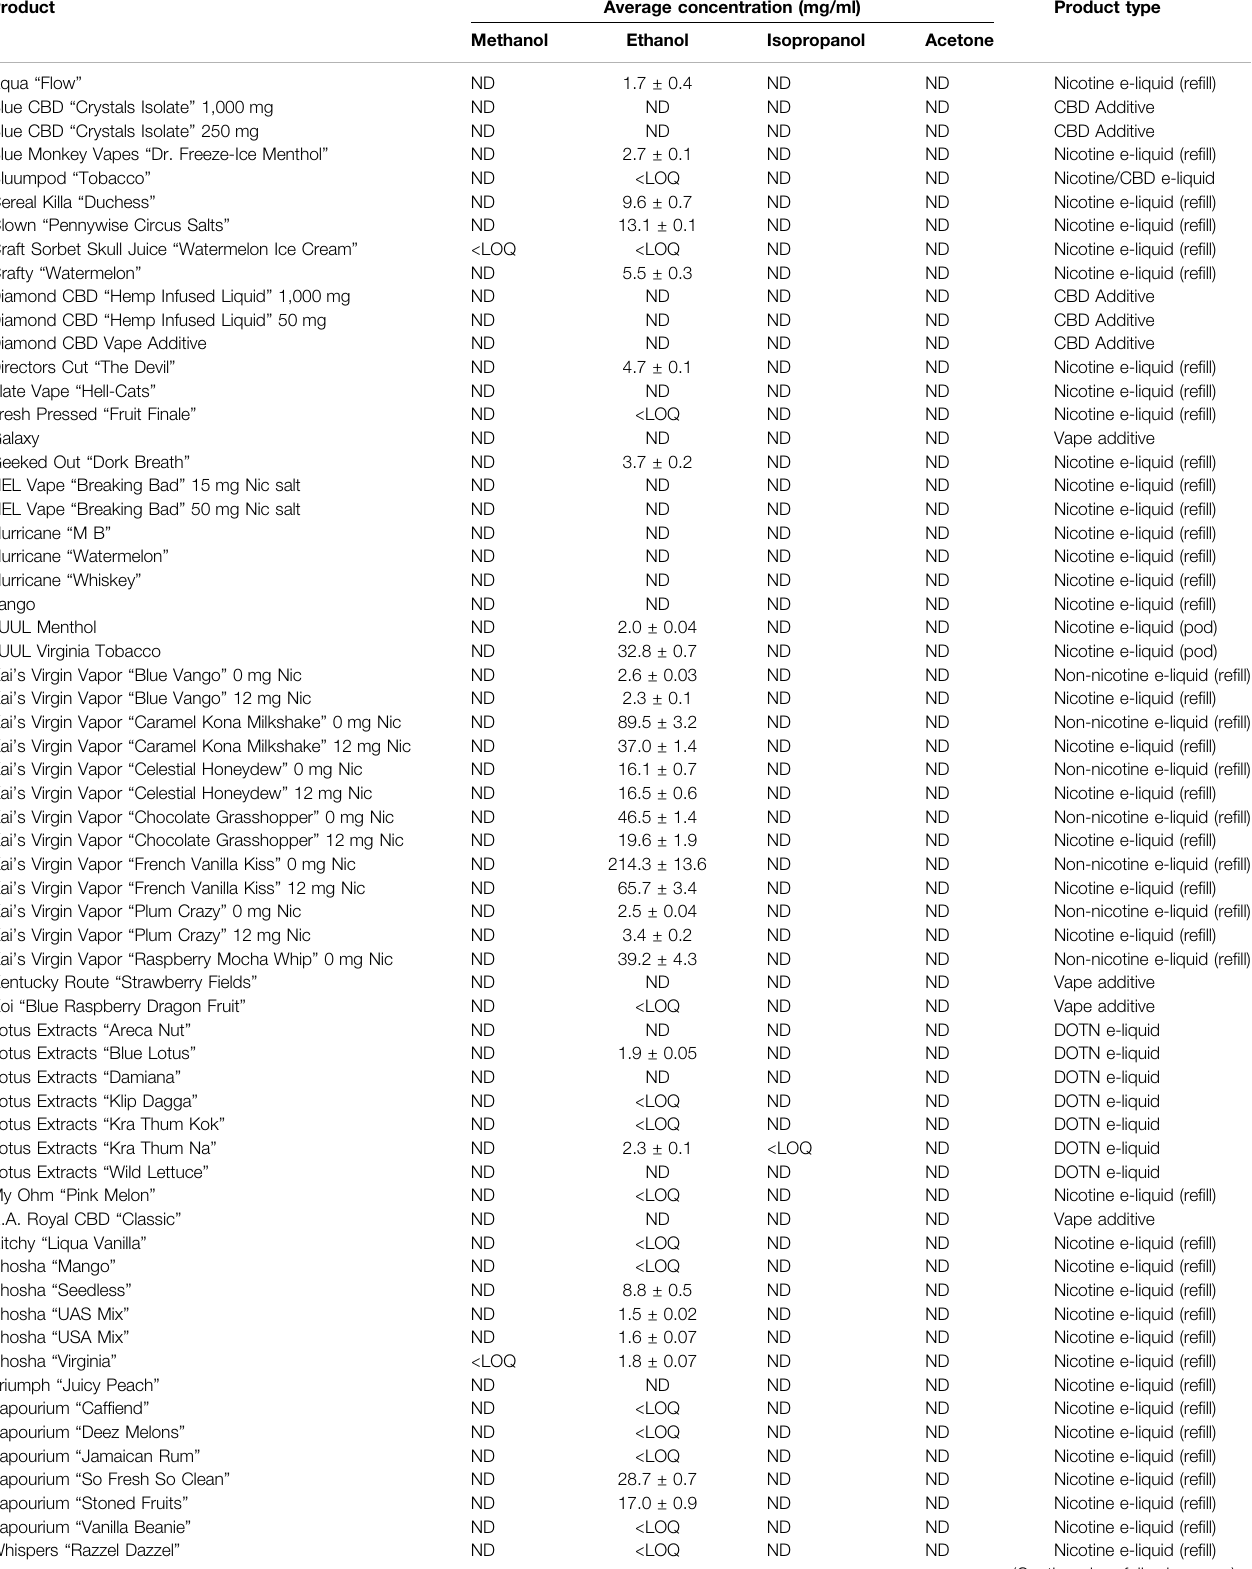
TABLE 5 | Ethanol concentrations in